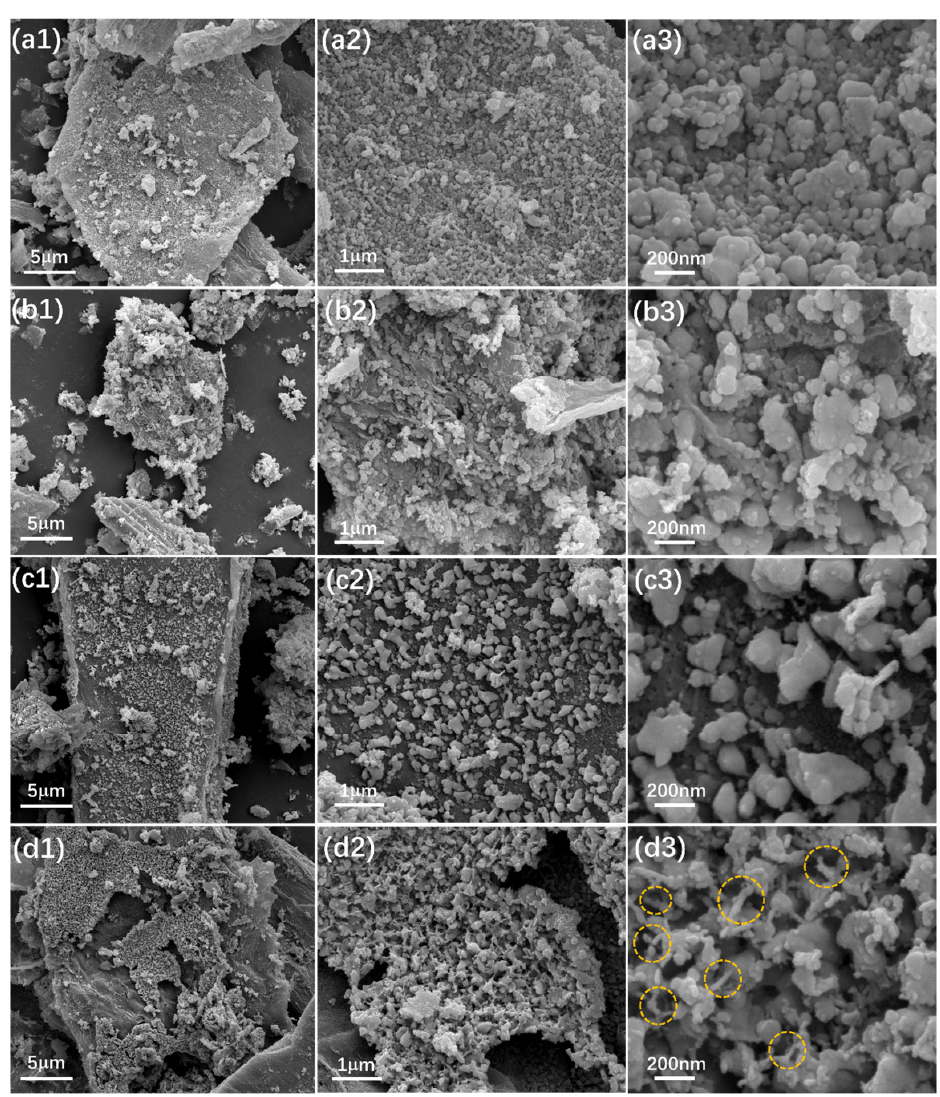
Figure 3. SEM images of C1 ( a1 – a3 ), C2 ( b1 – b3 ), C3 ( c1 – c3 ) and C4 ( d1 – d3